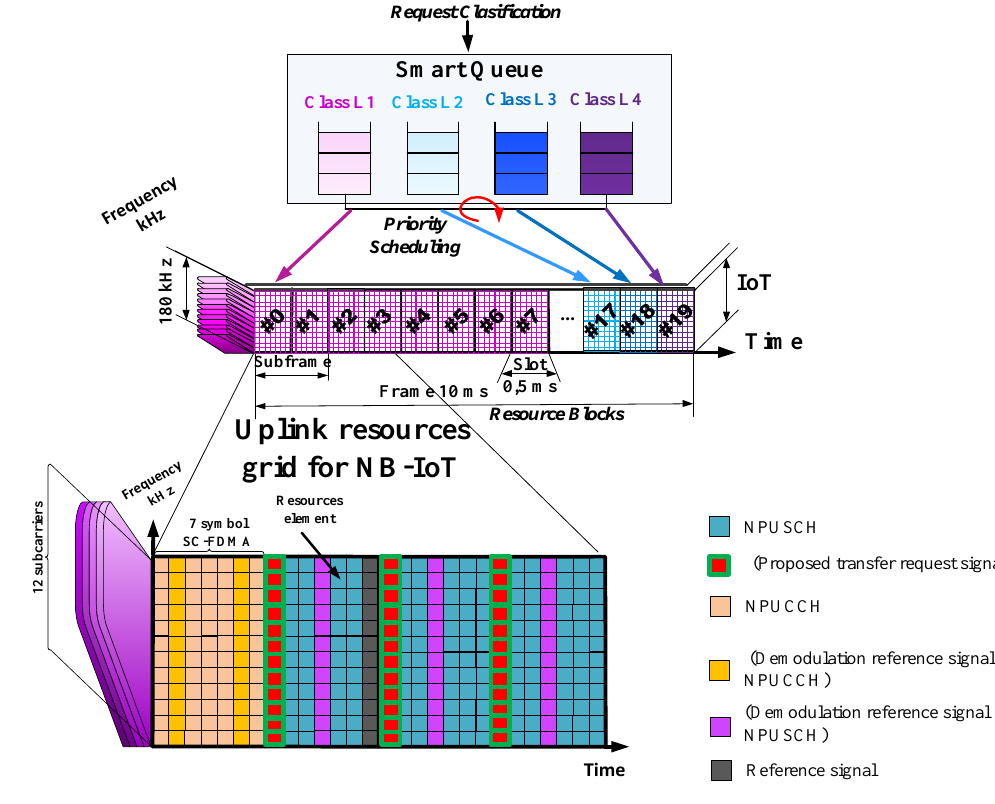
Figure 8. Resource grid of LTE/IoT for the uplink channel.